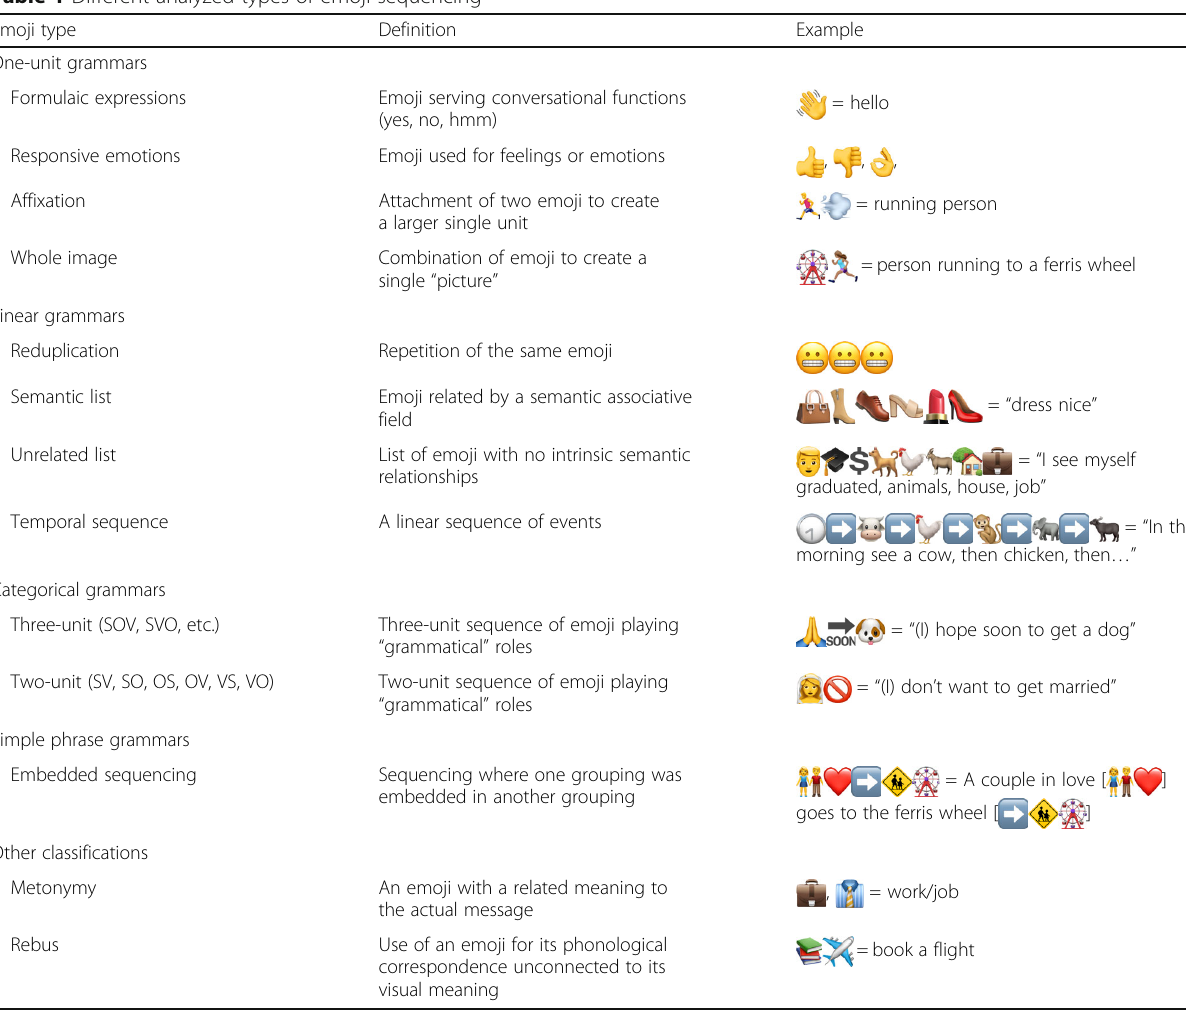
Table 1 Different analyzed types of emoji sequencing Emoji